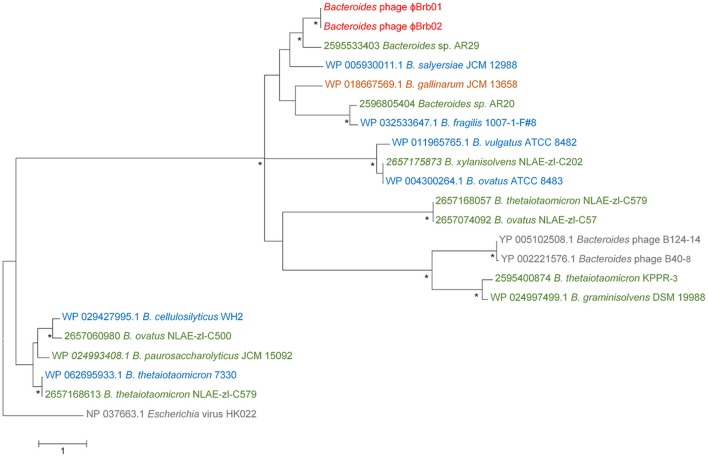
Maximum likelihood phylogeny of the phage terminase large subunit (TerL) proteins of the Bacteroides phages ϕBrb01 and ϕBrb02, the virus reference phages B124-14 and B40-8 and TerL protein sequences obtained from the bacterial genome sequences of 17 Bacteroides isolates, including 10 sourced from ruminants. The tree with the highest log likelihood (−18,869.80) based on the Le Gascuel model (Le and Gascuel, 2008) and a gamma distribution with five categories is shown. This tree used a total of 1,094 amino acid positions and is drawn to scale, with branch lengths measured in the number of substitutions per site and is rooted with the TerL protein sequence of the Escherichia virus HK022. Bootstrap supports greater than 85%, based on 1,000 replicates, are indicated (*). The TerL proteins of the Bacteroides phages ϕBrb01 and ϕBrb02 are colored red (•). For all other TerL protein sequences, the phage or bacterial genome names and accession numbers are detailed and colored according to the environmental isolation source, including • ruminant origin (rumen fluid, feces and bovine waste); • sewage (waste primarily of human origin); • human origin (gut and patient samples, excluding sewage); and • other gut material (chicken gut).